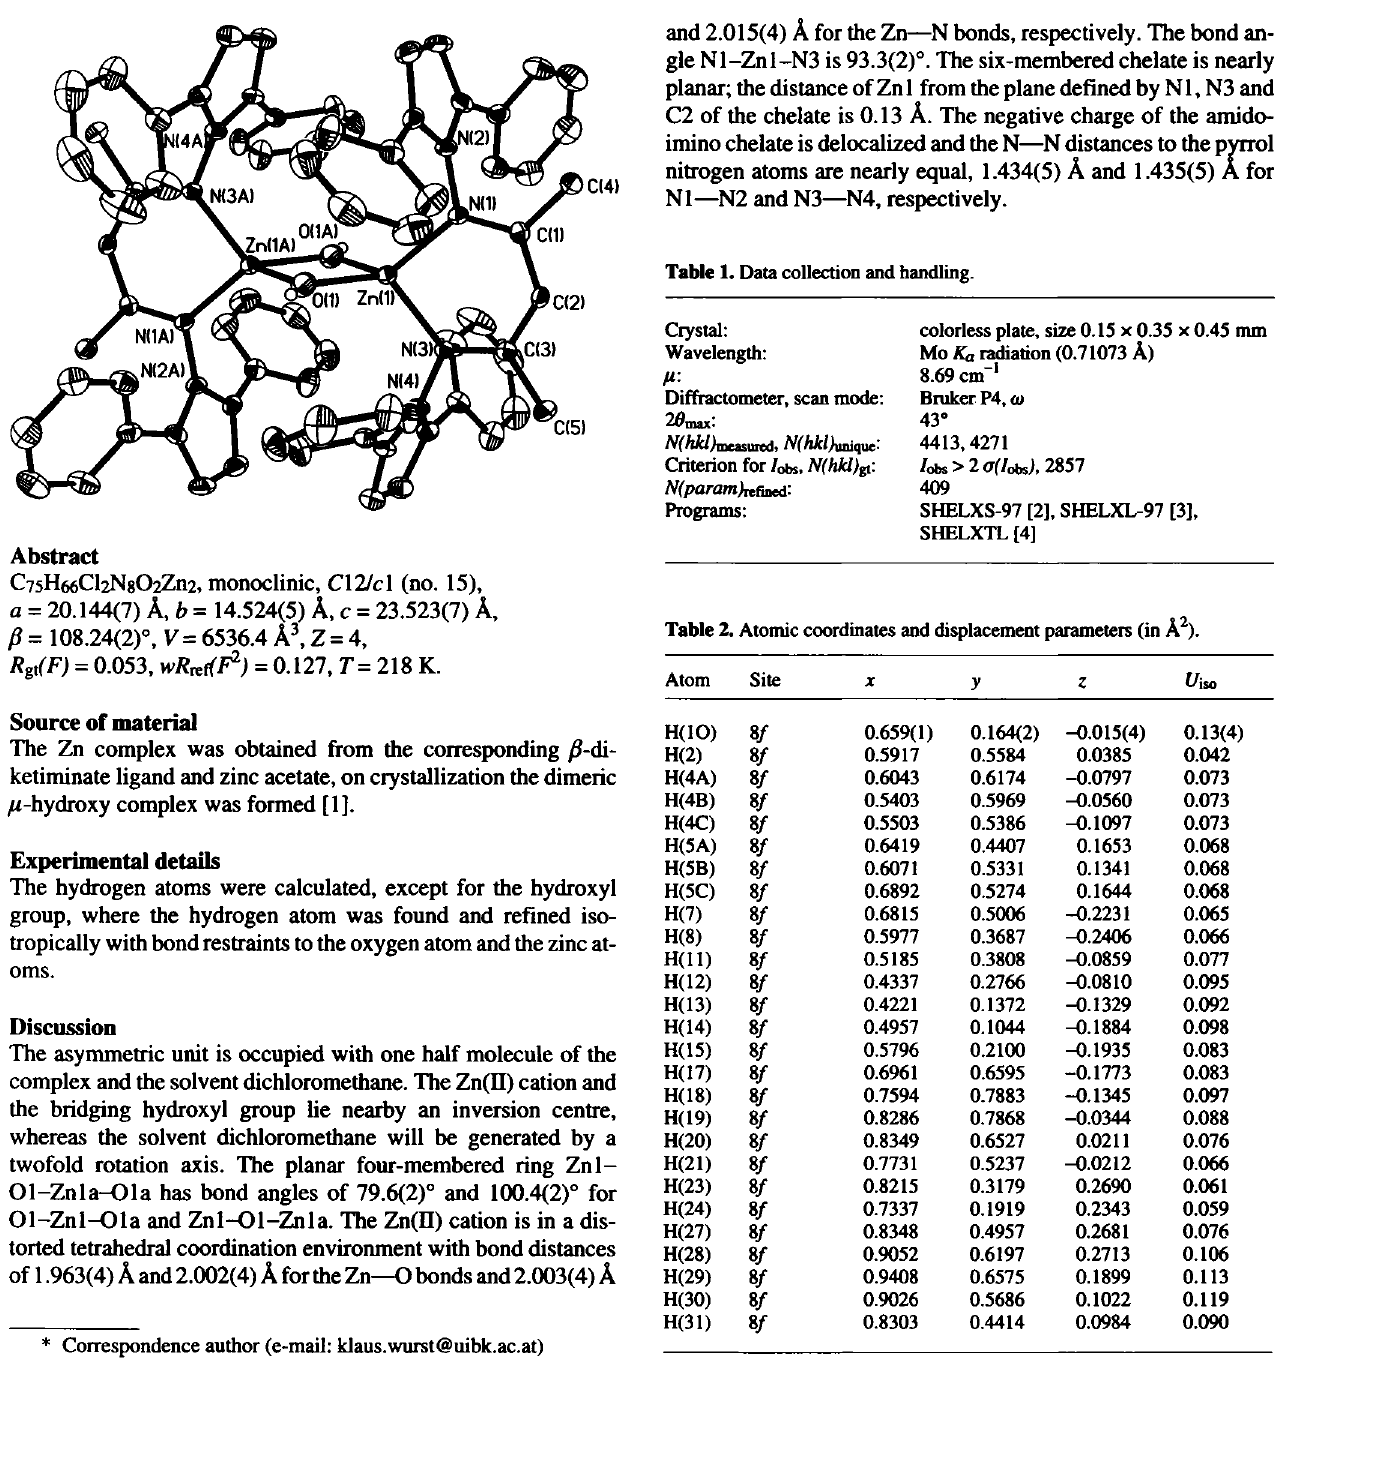
Table 1. Data collection and handling.